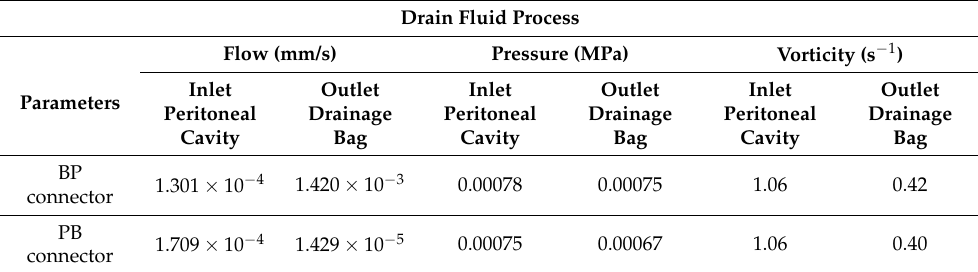
Table 8. Flow, pressure, and vorticity behavior of the fluid in the BP and PB connectors in the drainage process.